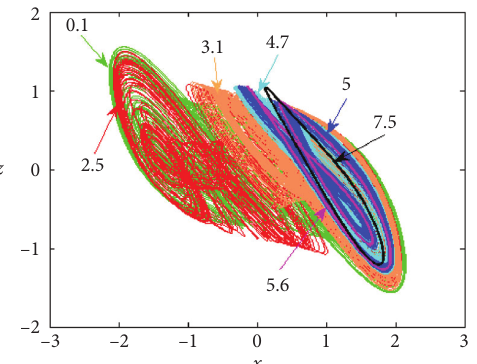
Figure 9: The coexistence of infinite number of attractors on x - z plane with different initial condition u (0), the different attractors corresponding to the different values of u (0) are marked with different